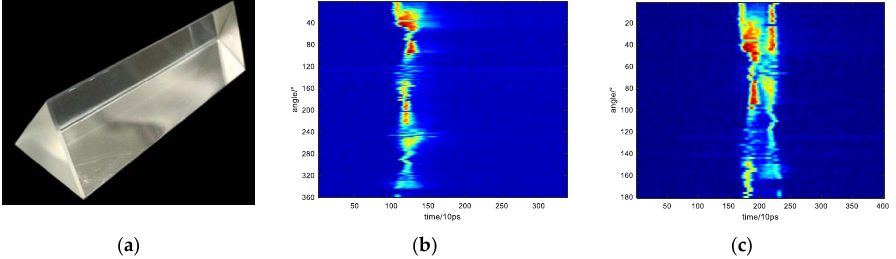
Figure 14. ( a ) Far-field target; ( b ) laser reflection projection data after registration; ( c ) converted projection data in complete angle.